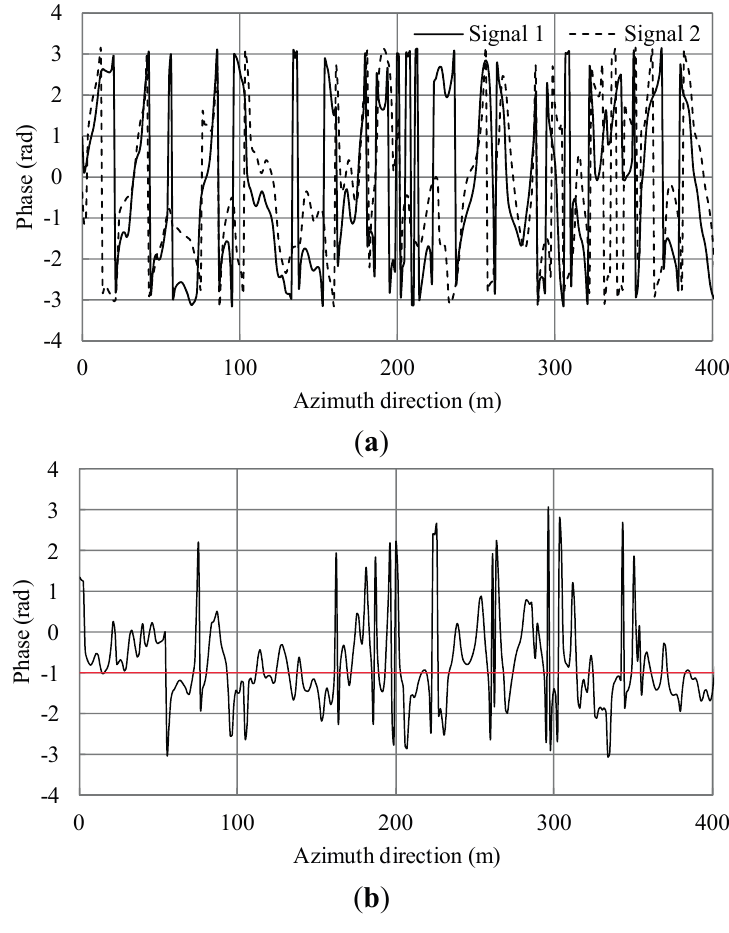
Figure 7. Simulation results of irregular waves for wind speed 5 m/s. ( a ) Phase of simulated SAR signals of master and slave antennas in the azimuth direction; ( b ) Phase differences of (a). The black line shows the phase differences. The red line shows the average.